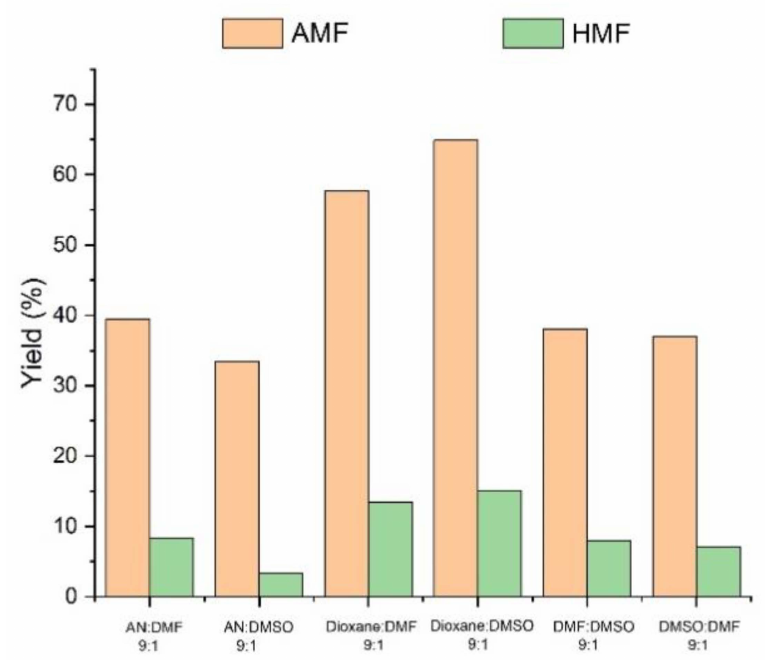
Figure 6. The yield of AMF and HMF after the dehydration of DAF in a dual-solvent system. There was a noticeable change in AMF yield in the mixture of dioxane with DMF or DMSO. We expected that the polar aprotic solvents (i.e., acetonitrile, DMF, and DMSO), which are widely used to synthesize HMF from fructose, would be suitable for DAF dioxane with DMF or DMSO produced higher AMF yields (58% and 65%, respectively) than the other polar aprotic solvent mixtures. The AMF and HMF yields were the